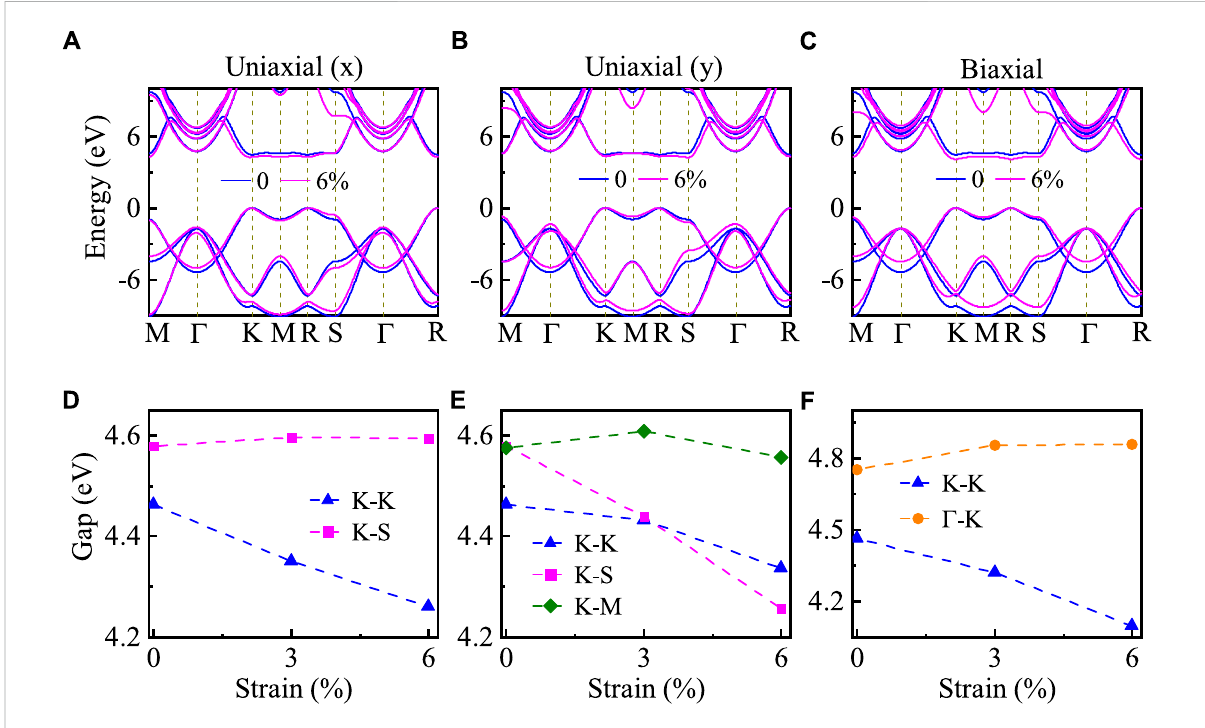
FIGURE 2 The band structures of the monolayer hBN with the uniaxial strain along (A) the x direction, (B) the y direction, and (C) the biaxial strain along boththe x and y directions.Theblueandmagentacurvesarefor ε =0and ε =6%,respectively. ε =0isthestrain-freecase.Thecorrespondingstrain- dependent direct and indirect band gap in the monolayer hBN are shown in (D) − (F)